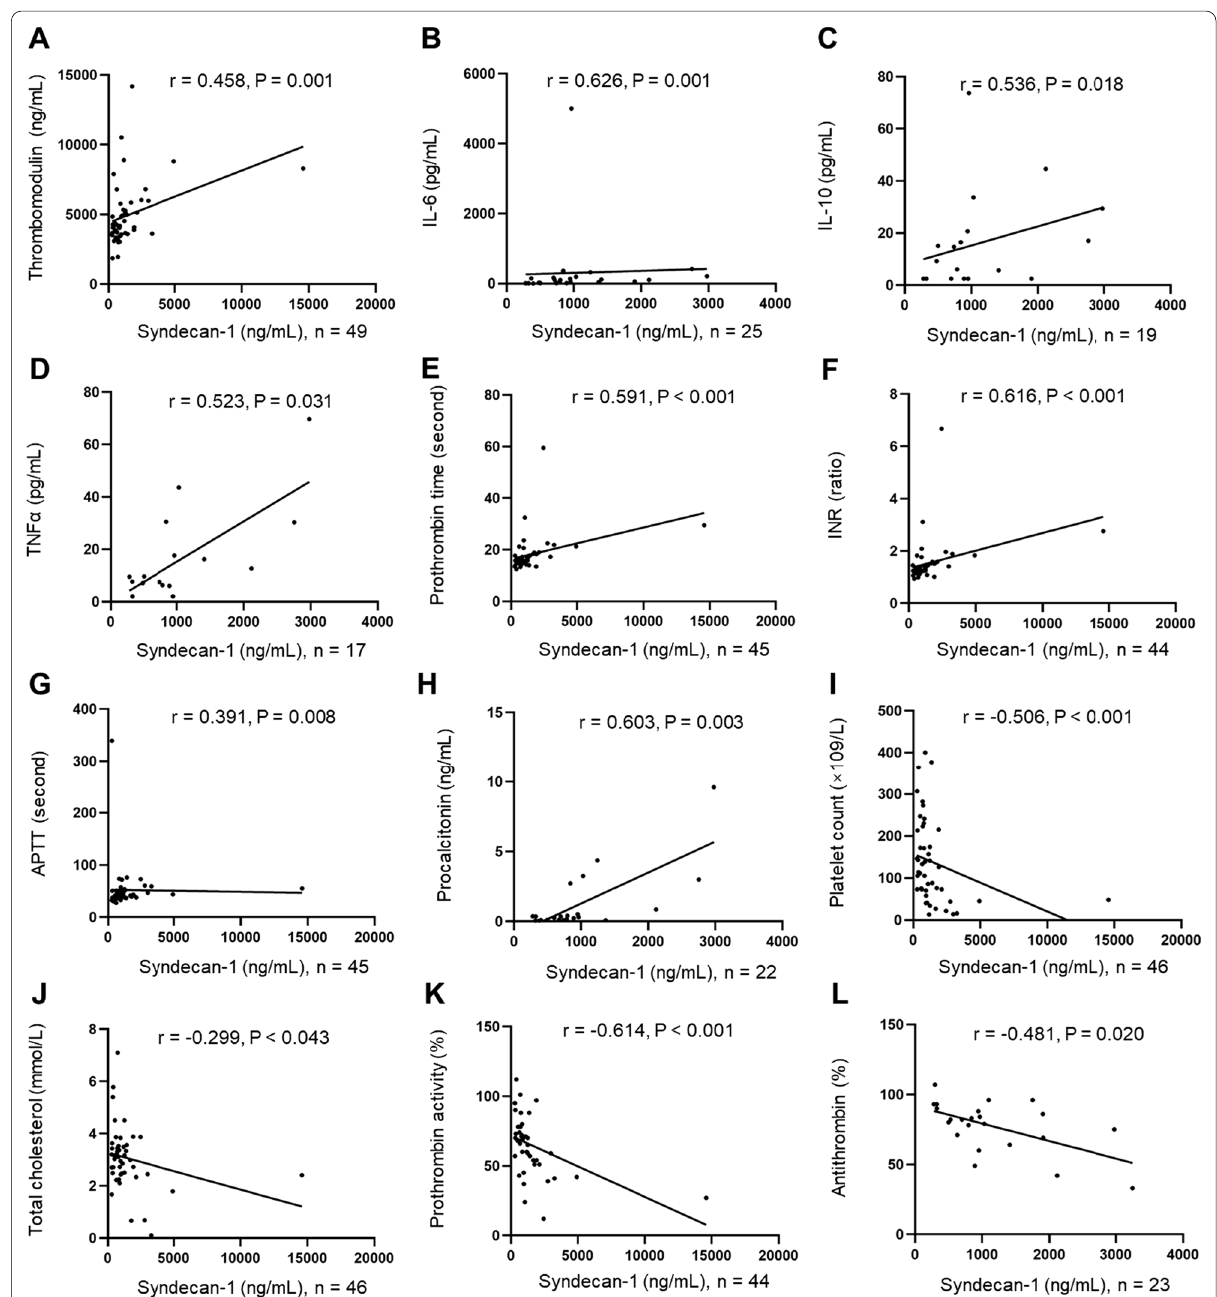
Fig. 3 Associations between Syndecan-1 levels and laboratory parameters. A – G The level of Syndecan-1 was significantly and positively associated with these laboratory parameters. I – L The level of Syndecan-1 was significantly and negatively associated with these laboratory